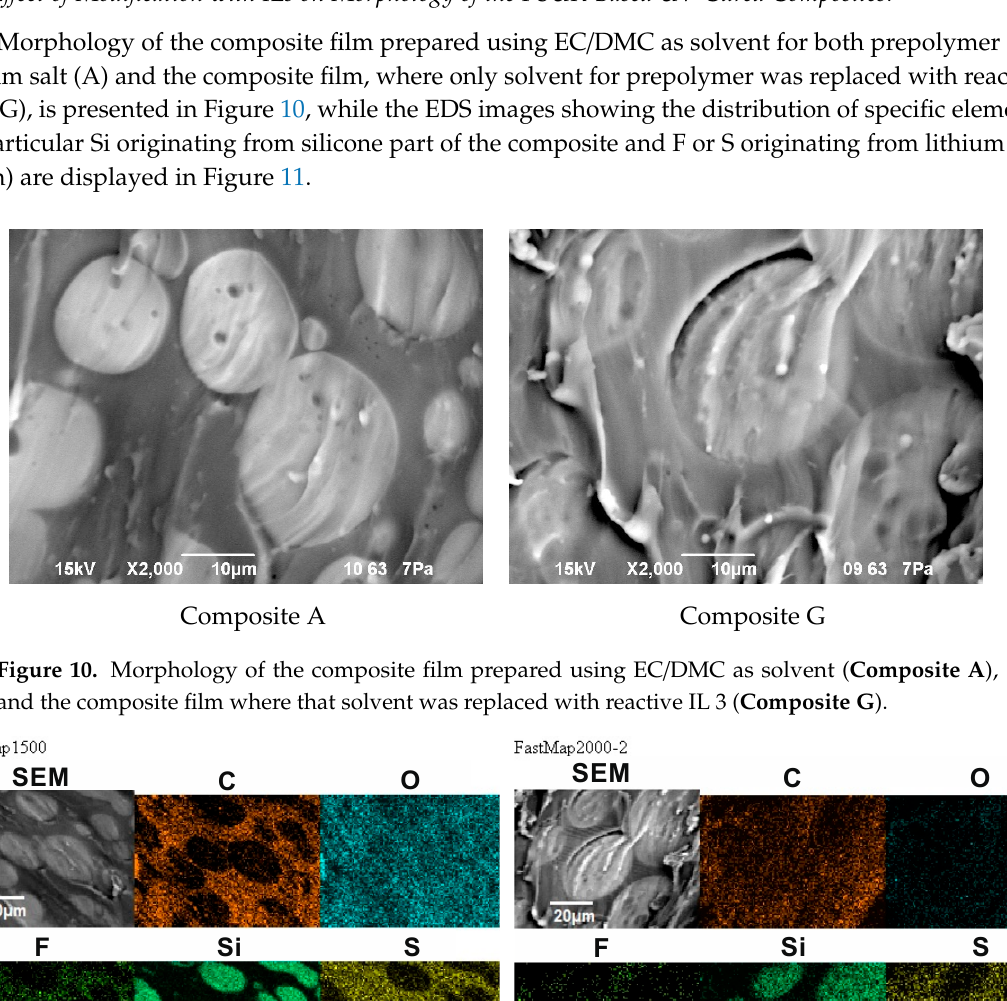
Figure 11. Distribution of elements in the composite film prepared using EC/DMC as solvent ( Composite A ) and the composite film where that solvent was replaced with reactive IL 3 ( Composite G